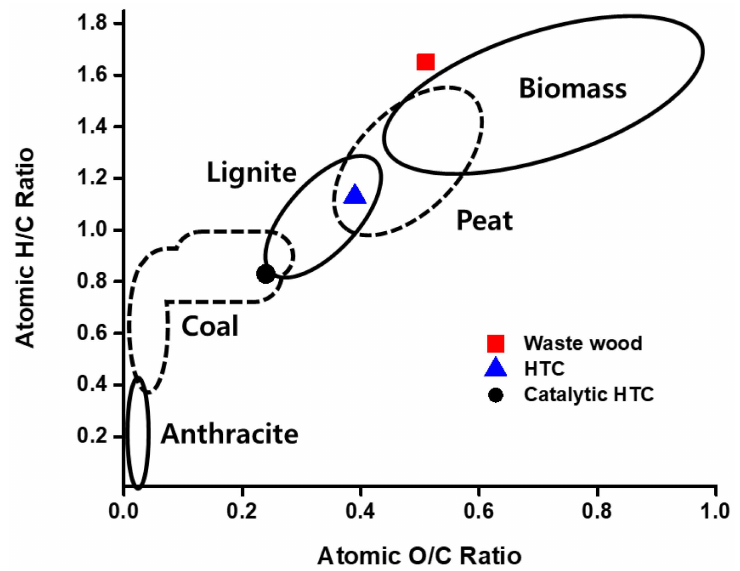
Figure 4. Van Krevelen diagram of waste wood and biosolid fuels produced by different HTC processes at the pilot scales.